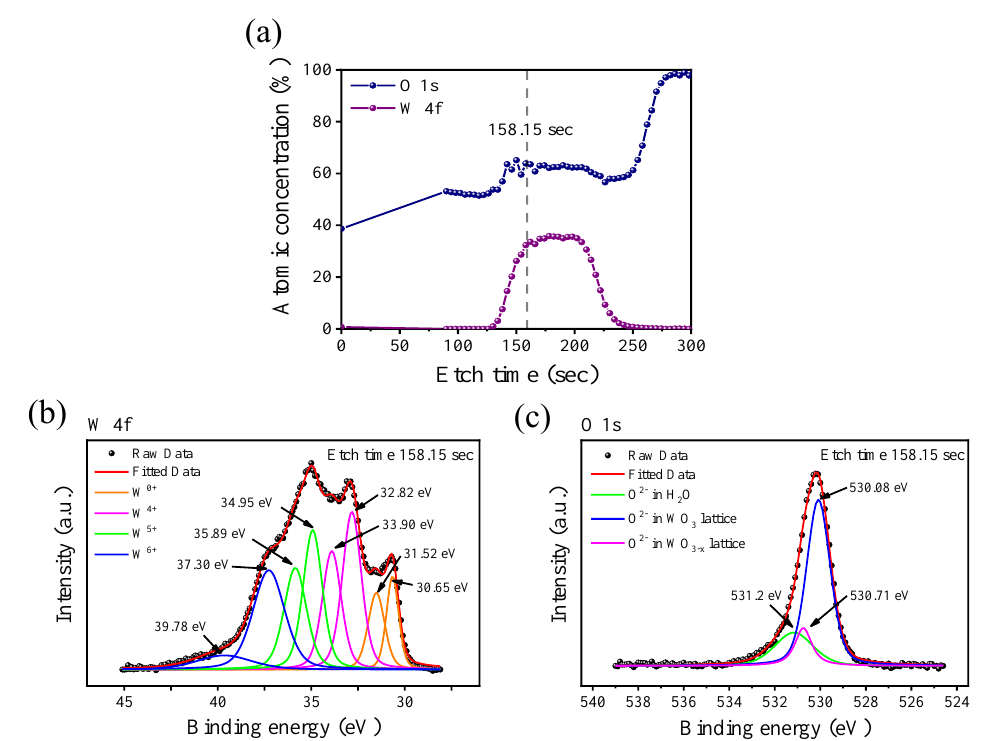
Figure 2. ( a ) Atomic concentration in accordance with the etch time. Only the information about W 4f and O 1s is specified. ( b ) Four different doublets of W 4f core level spectra in the etch time of 158.15 s. ( c ) O 1s core level spectra in the etch time of 158.15 s.